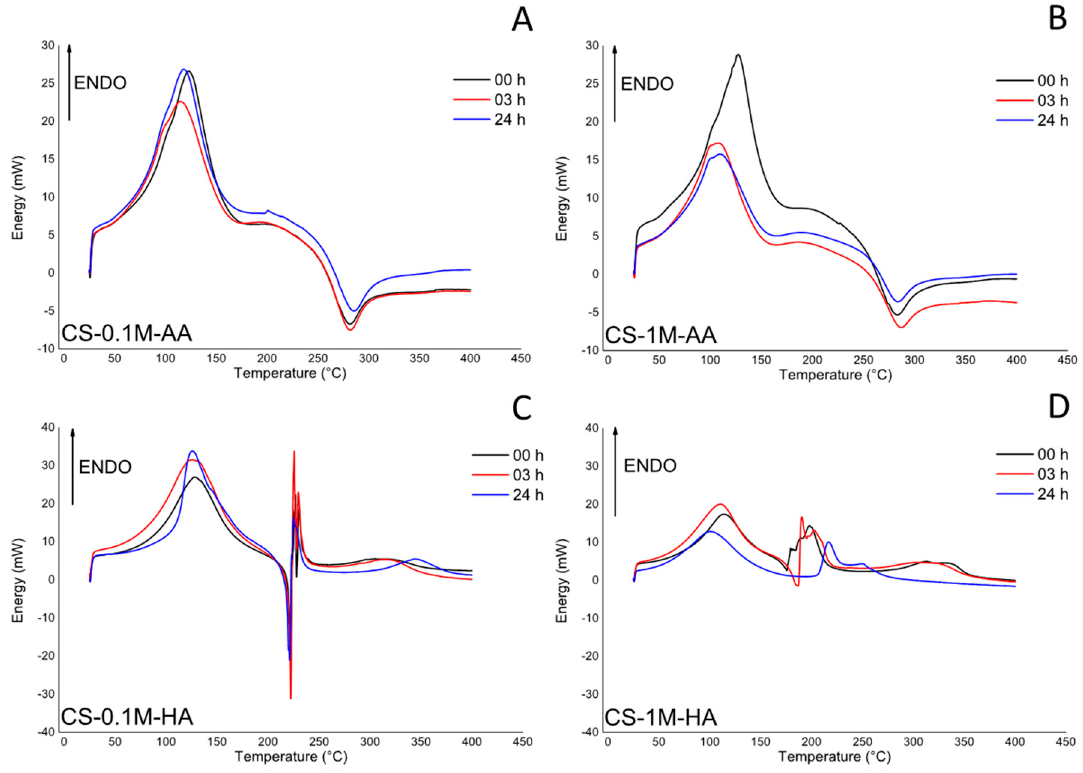
DSC thermograms of chitosan samples stored ad different time instants at 80 ˝ C. ( A ) CS-0.1M-AA; ( B ) CS-1M-AA; ( C ) CS-0.1M-HA ; ( D ) CS-1M-HA.